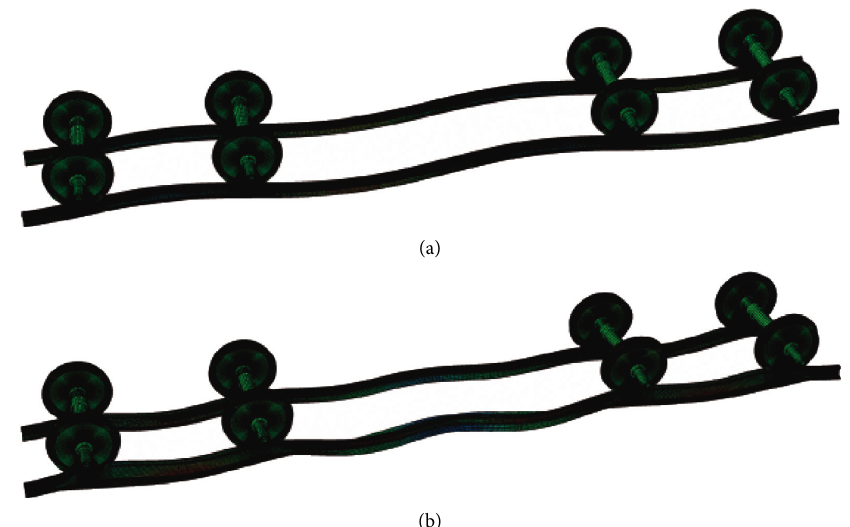
Figure 12: Natural vibration mode of track structure in Shi-Pan down section. (a) Typical vibration modes of curved track at 75Hz. (b) Typical vibration modes of curved track at